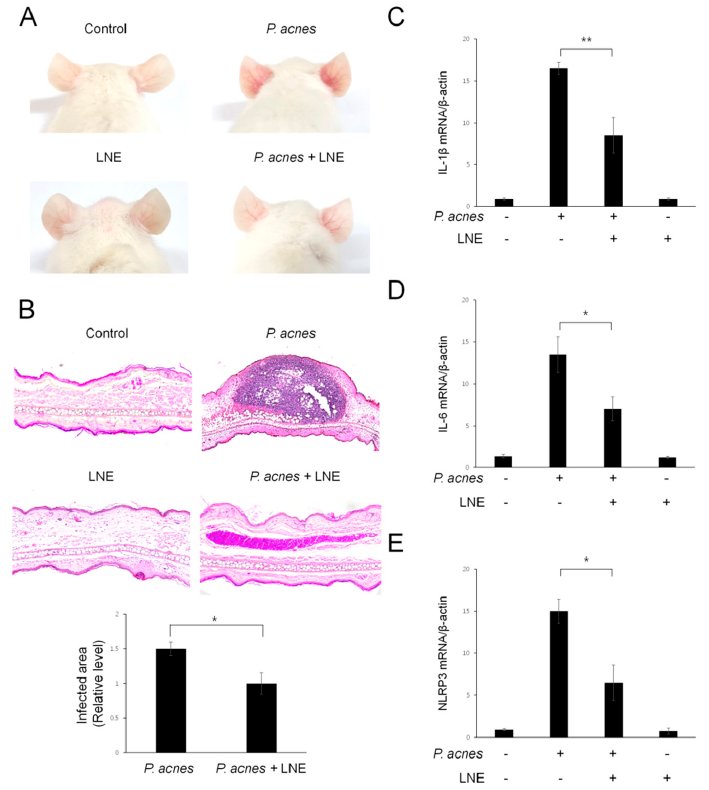
Figure 7. Inhibitory effects of LNE in a mouse acne model. Live P. acnes (1 × 10 8 CFU) were inoculated